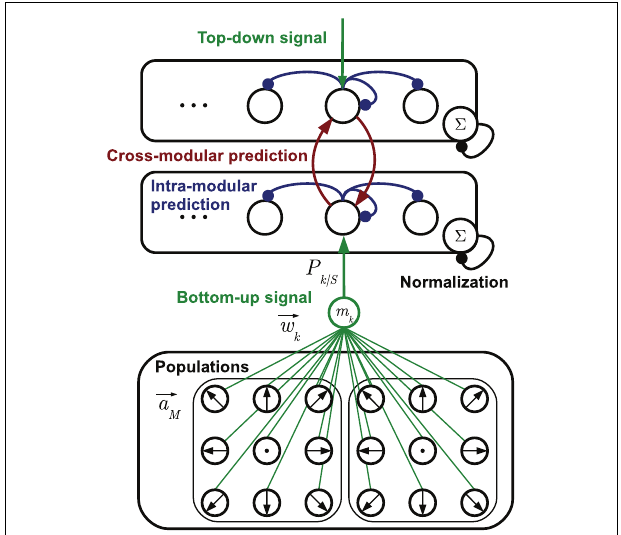
FIGURE 2 | Two stochastic state layers in hierarchical compound . The bottom-up sensory state recognition signal is provided by multiple populations of tuned cells. The signals P k | S provided by the match m k between cell prototypes ⃗ w k and the current stimulus ⃗ a M are indicated by the green connection diagram. Analogously, top-down recognition signals can be defined. Lateral recurrences in blue represent state transition probabilities, including the self-recurrence to preserve a state. Red lines denote cross-modular predictions of states. Arrow head lines indicate signals that are summed up by a cell, while bullet head lines indicate modulations of cell inputs [cf. equation